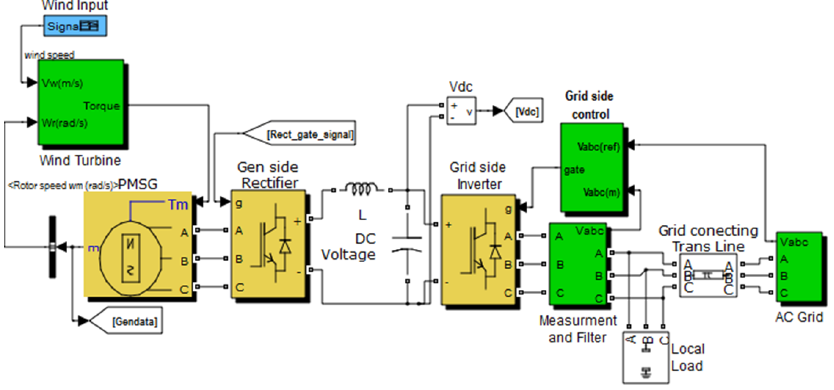
Figure 6. Small wind energy conversion